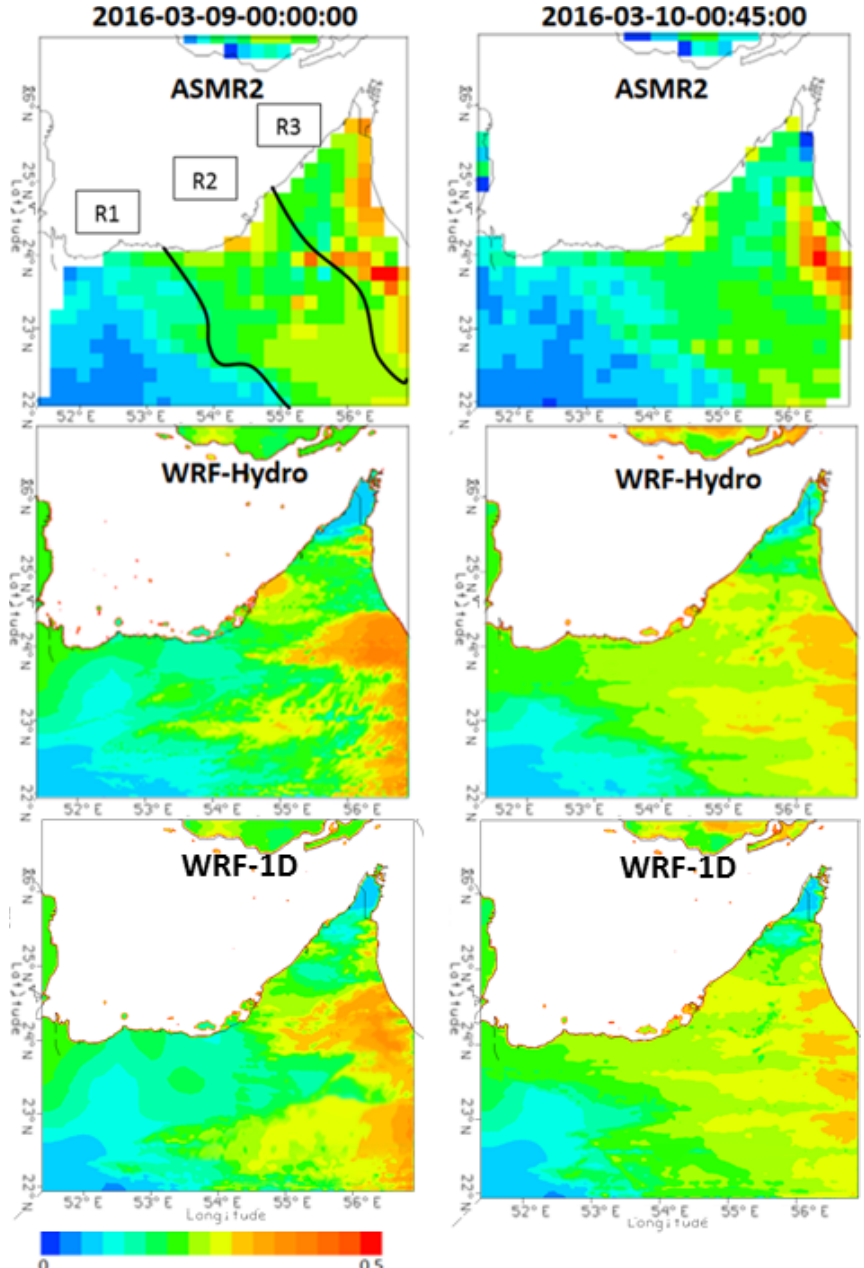
Figure 10. Comparison of simulated WRF-Hydro and retrieved AMSR2 soil moisture during (9 March 2016, 00:00:00) and after (10 March 2016, 00:45:00) the event.